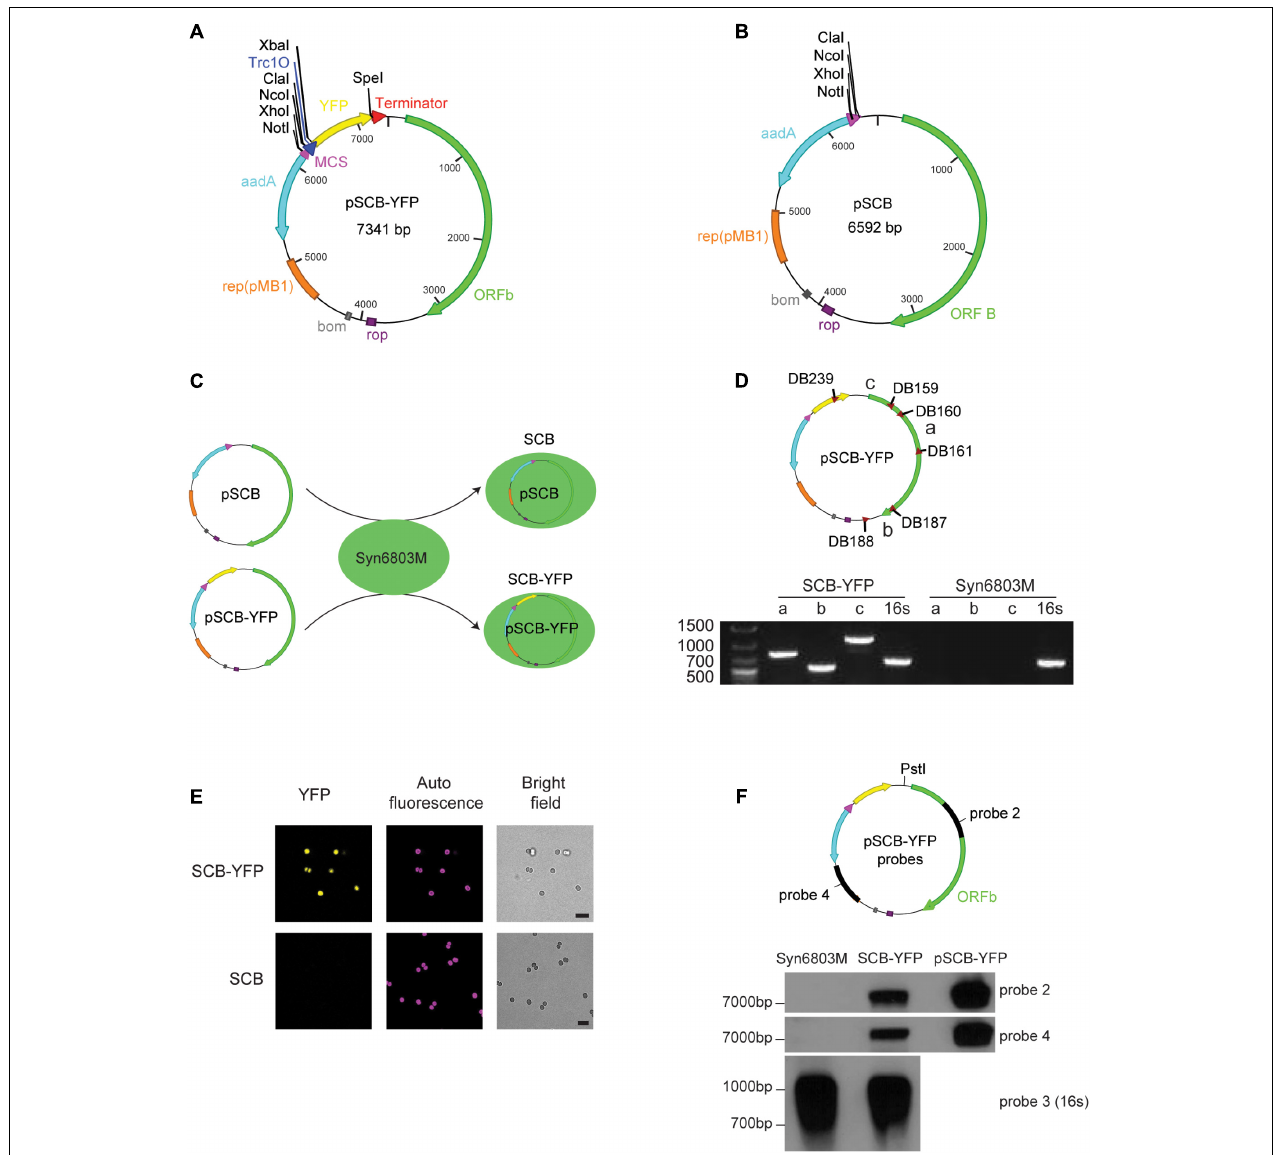
FIGURE 2 | pSCB-YFP shuttle vector built and its stability assay. (A) pSCB-YFP shuttle vector was built to test whether ORFb and its flank region can support plasmid replication in Syn6803. This plasmid contains the E. coli pMB1 origin of replication (orange bar); the rop gene (purple bar), which encodes a restrictor of plasmid copy number; bom site for conjugative transformation (gray box); Sp cassette ( aadA ) for spectinomycin selection (light blue arrow); The YFP reporter gene (yellow arrow) was driven by a Trc1O promoter (blue triangle), and an XbaI site downstream of the Trc1O promoter and a SpeI site right before the B0015 terminator (red triangle) were also added. For cloning, a multiple cloning sites (MCS; purple triangle) was introduced which contains four unique enzyme sites as listed. (B) pSCB has similar components as pSCB-YFP except YFP gene was removed from the plasmid. This vector was used as negative control for SP8 confocal microscope observation. (C) pSCB and pSCB-YFP plasmids were conjugated into Syn6803M, generating stains SCB and SCB-YFP, respectively. (D) Three pairs of primers were designed for pSCB-YFP to test the presence of the plasmid in SCB-YFP exconjugants. Primer sets DB160 and DB161 (amplicon a), DB187 and DB188 (amplicon b), and DB239 and DB159 (amplicon c) can amplify bands of 790, 545, and 1109 bp, respectively. SCB-YFP showed positive bands for all three primer sets which were verified by sequencing, while no bands were detected from wild-type Syn6803M, as expected. 16S rRNA primers were used as PCR positive control for both strains. (E) Observation of SCB-YFP and SCB exconjugants with Leica SP8 confocal microscope under YFP, DsRed and bright field channels. We can see that SCB-YFP showed YFP fluorescence under the channel, while SCB negative showed nothing. Exconjugants’ auto-fluorescence and bright field pictures are shown alongside the fluorescence images. Scale bar indicates 5 µ m in length. (F) Two probes (probe 2 and probe 4) were used to test pSCB-YFP stability in SCB-YFP exconjugants. Probe 2 is the same as in Figure 1C , probe 4 is a PCR amplicon based on primer set DB245 and DB246 using pSCB-YFP as a template. PstI which is the unique enzyme site on pSCB-YFP plasmid was used for total DNA digestion. PstI digested pSCB-YFP plasmid from E. coli was used as a control to indicate the size of the intact pSCB-YFP vector. 16S rRNA probe which is the same as in Figure 1B was used as Southern blot positive control. DNA hybridization results showed that no hybridization was detected in the Syn6803M negative control, and a band corresponding to the size of linear pSCB-YFP was detected in SCB-YFP strain with both probes.